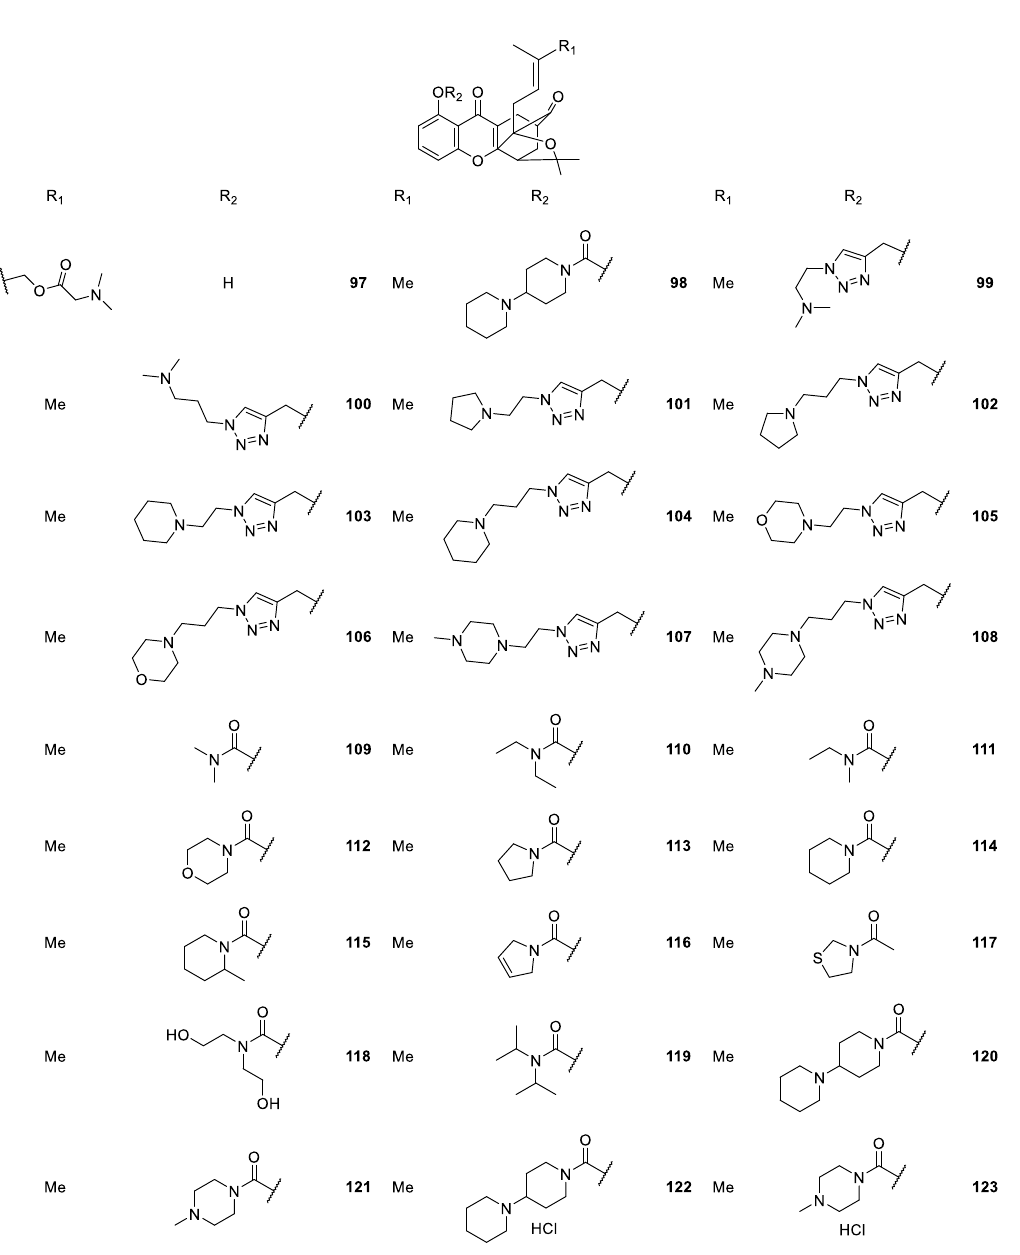
Figure 11. Structures of caged xanthones 97 – 123 , with antitumor activity.